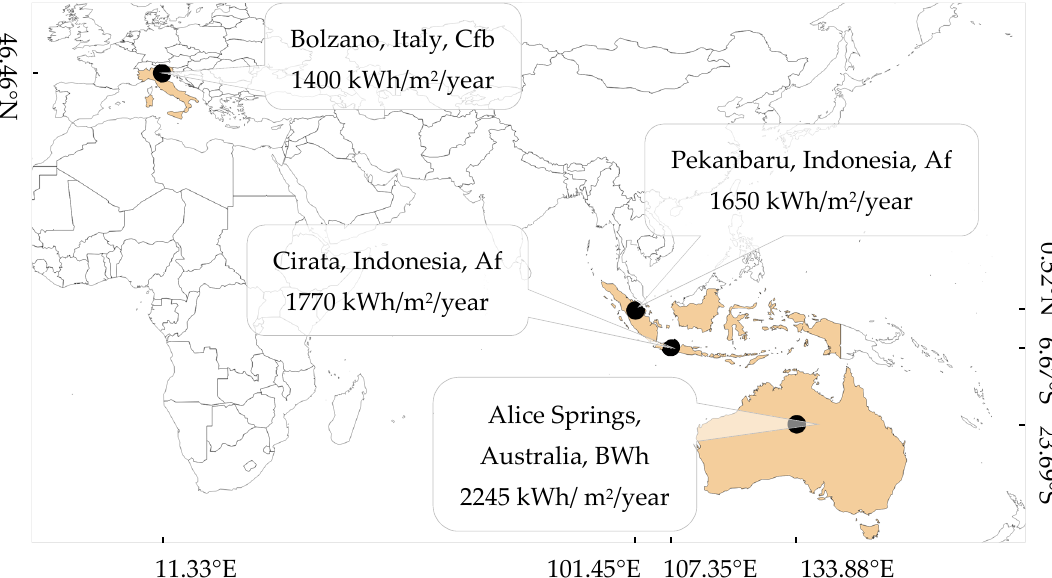
Figure 1. The geographical distribution of the photovoltaic (PV) systems, climate locations, and annual global irradiation on a horizontal surface (kWh / m 2 / year). The map is based on [37], irradiation data are obtained from Global Solar Atlas 2.0, a free, web-based application developed and operated by Solargis s.r.o. on behalf of the World Bank Group, with funding provided by the Energy Sector Management Assistance Program (ESMAP). For additional information: https://globalsolaratlas.info.